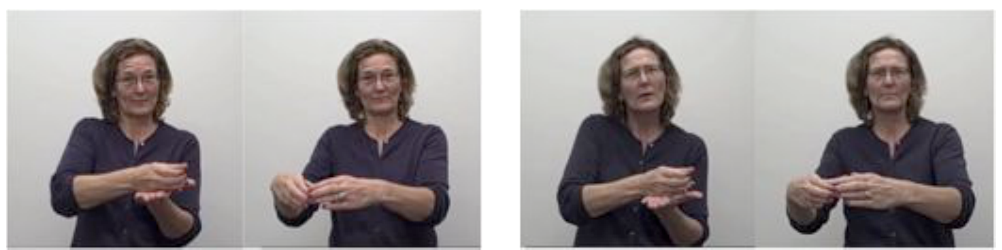
Figure 6 coord-shift(and) and coord-shift(or) used in the Coordination sentence